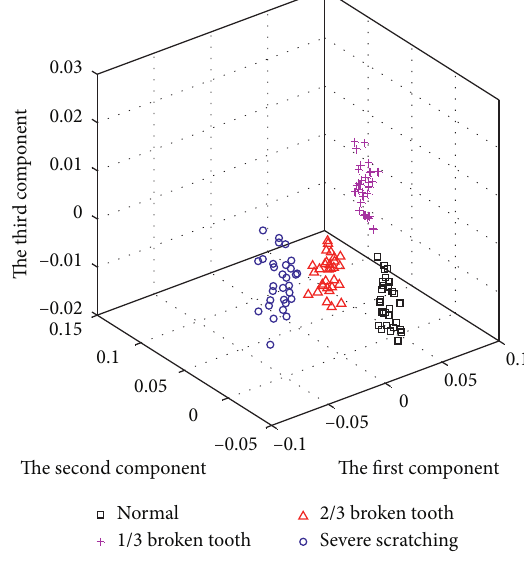
Figure 6: The 3D map of